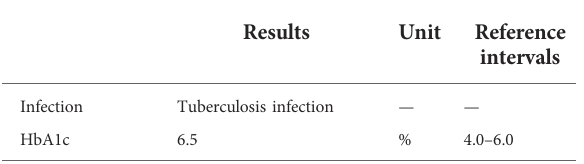
TABLE 1 Clinical characteristics of the patient in our present